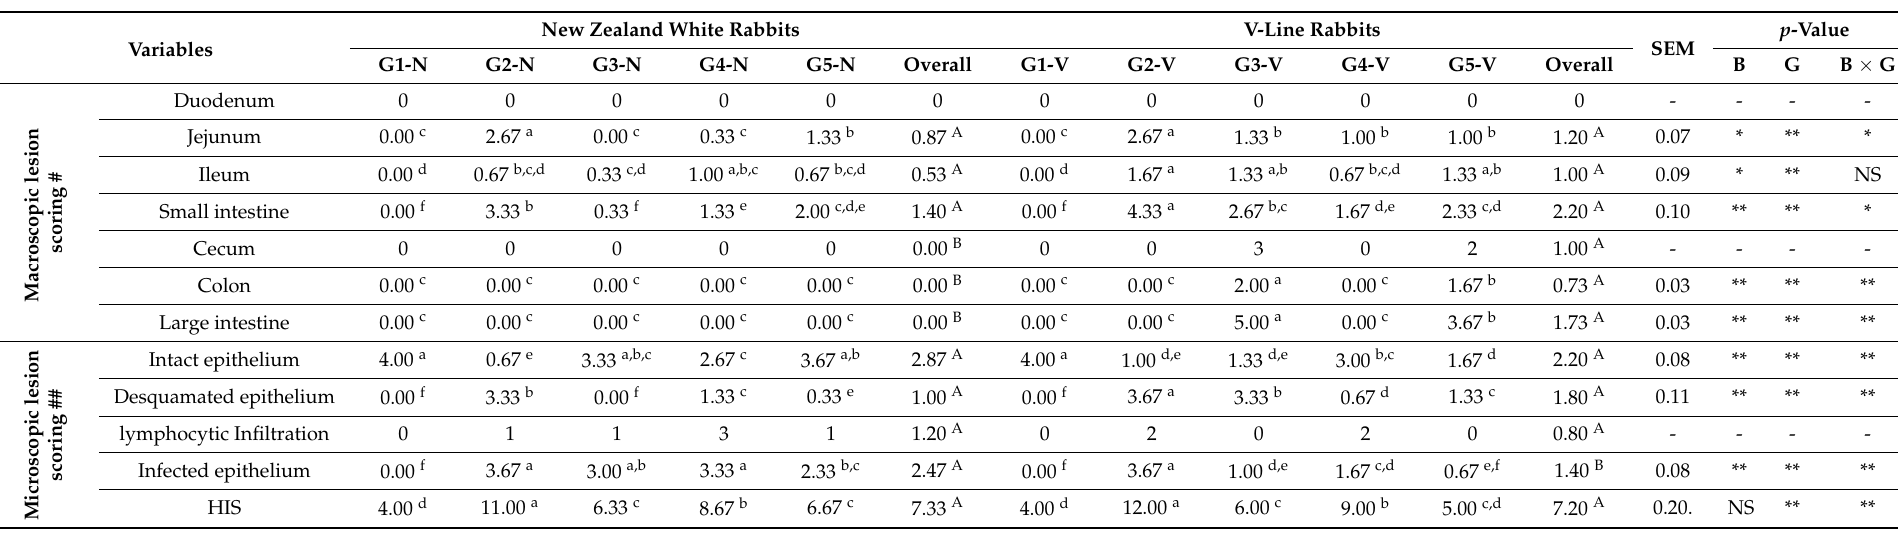
Table 5. Pathological lesion scoring in the intestines of the New Zealand white and V-line rabbits in response to coccidial infection and herbal extract treatment. Variables